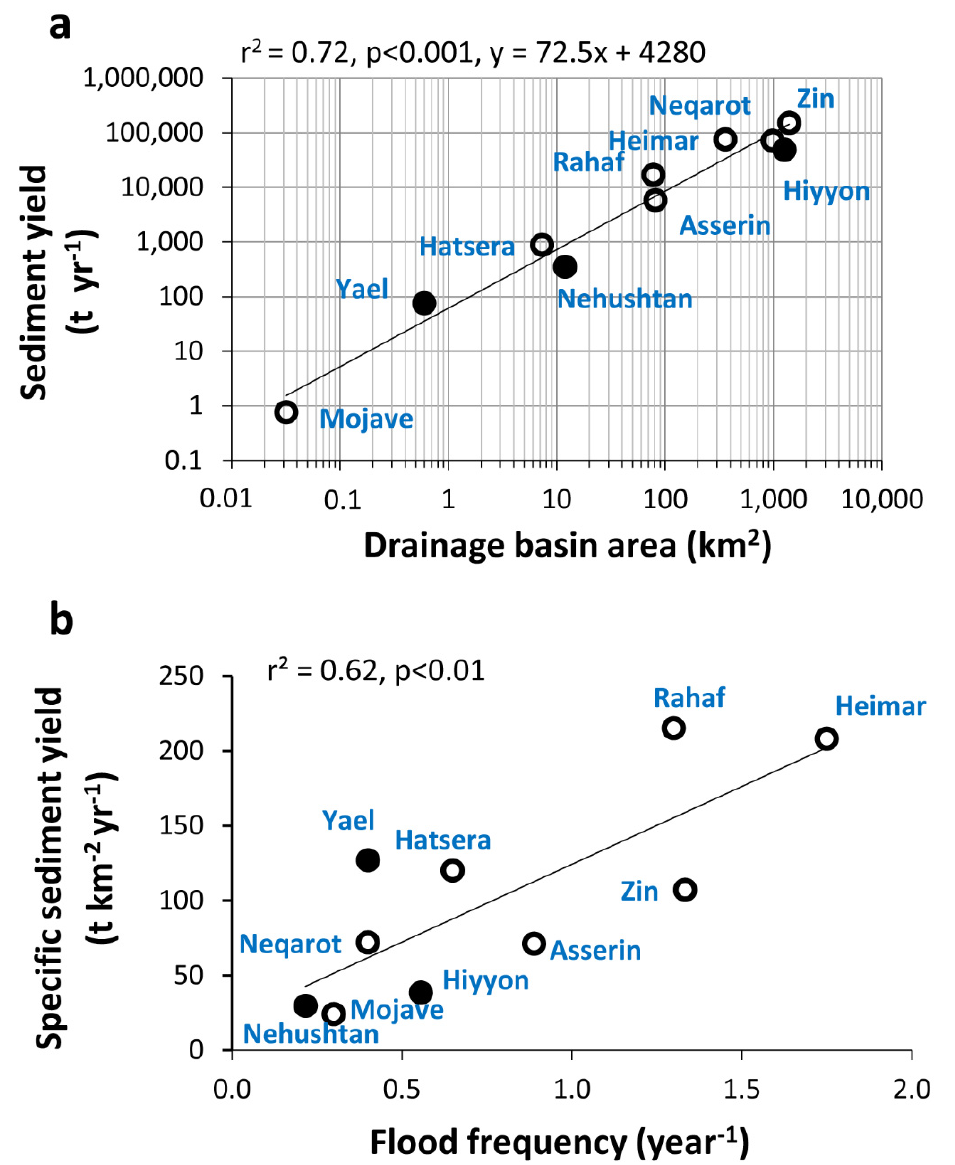
Figure 8. Variation of mean annual sediment yield with respect to drainage area ( a ) and of specific sediment yield with flood frequency ( b ) in drainage basins draining hyper-arid areas, based on Table 2. Flood frequency is calculated based on the number of events documented in reservoir deposits. Black circles denote basins in arid areas (<50 mm year − 1 rain).